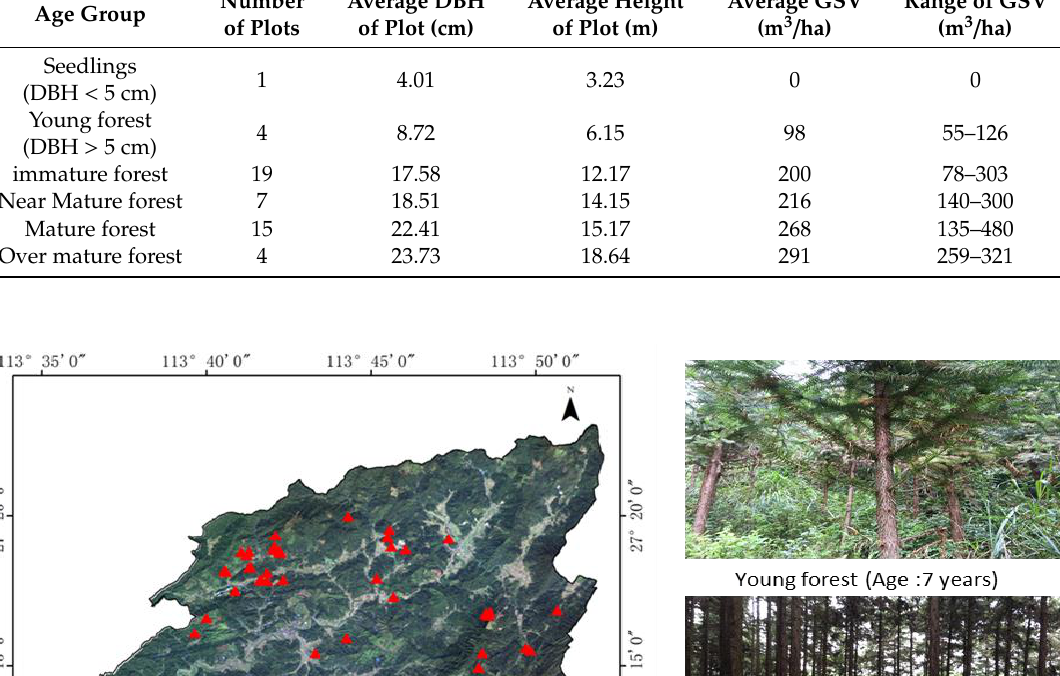
Table 2. Statistical parameters of stand variables for the ground measured plots.